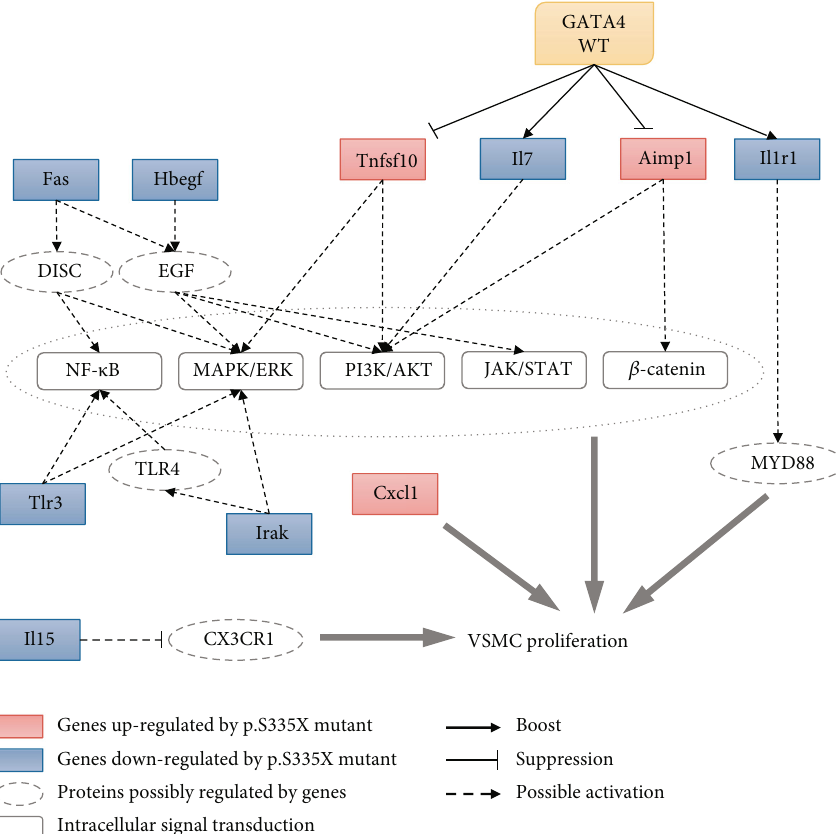
Figure 7: A schema illustrating the potential relationship between the regulation of RCSMC phenotype by GATA4 WT and MU and the DEGs and possible intracellular